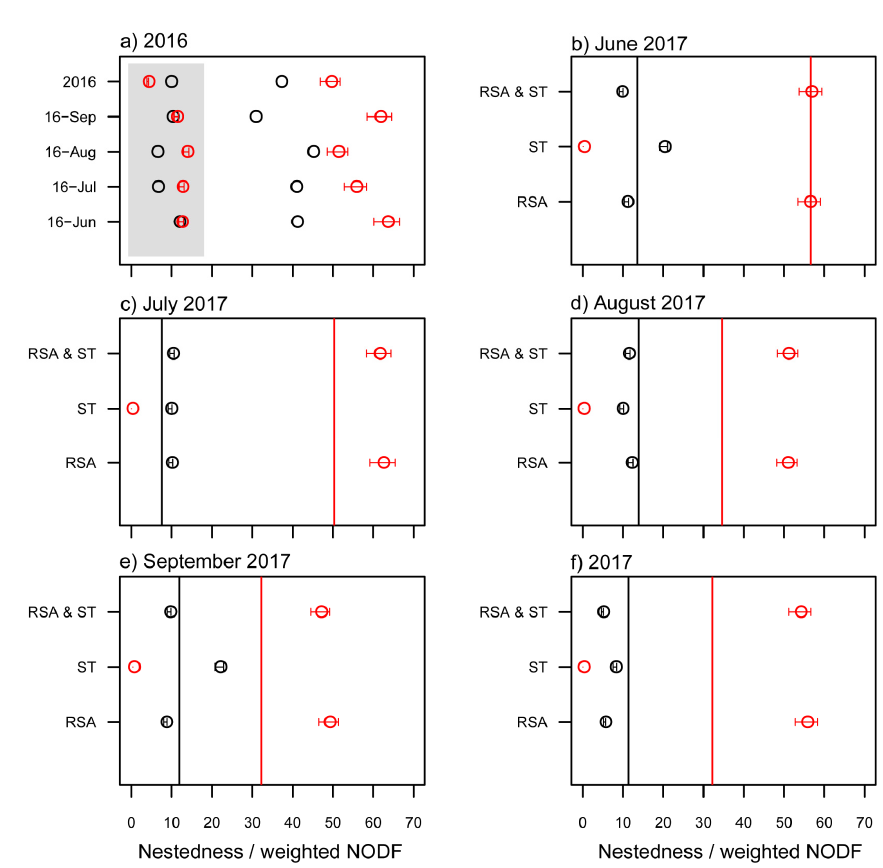
Fig 2. Comparison between observed and predicted structure parameters (estimate ± 95% confidence intervals) for the monthly and yearly networks. RSA, ST, and RSA & ST indicate the predicted pollination network based on the relative species abundance, species traits, and both, respectively. Nevertheless, the predicted network was based on RSA only in 2016 (a), where the black and red circles indicate the observed and predicted values, respectively, and the circles in the shaded and light areas are for “nestedness” and “weighted NODF”, respectively. For the other panels of 2017, the black and red circles, as well as the black and red lines, indicate the predicted “nestedness” and “weighted NODF”,